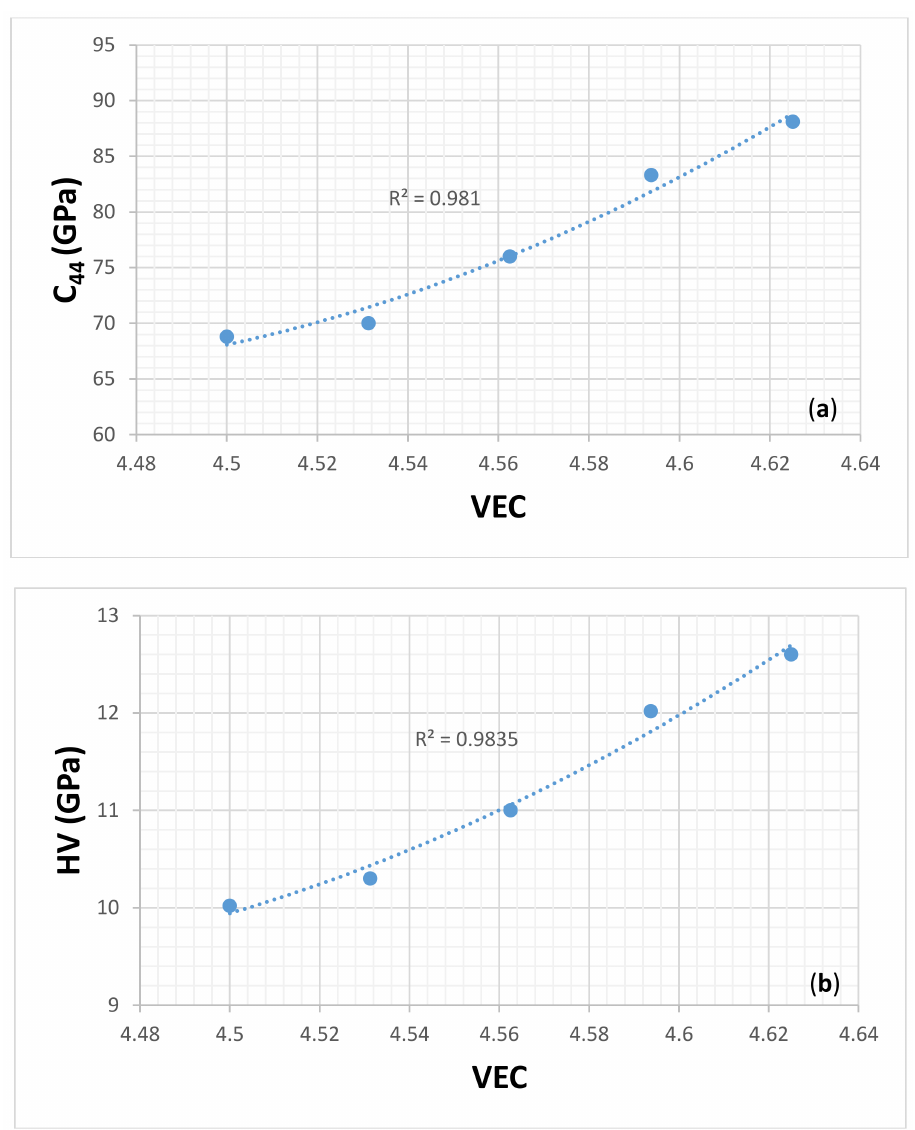
Figure 16. ( a ) C 44 versus VEC and ( b ) calculated hardness versus VEC of β (Nb,Ti) 5 Si